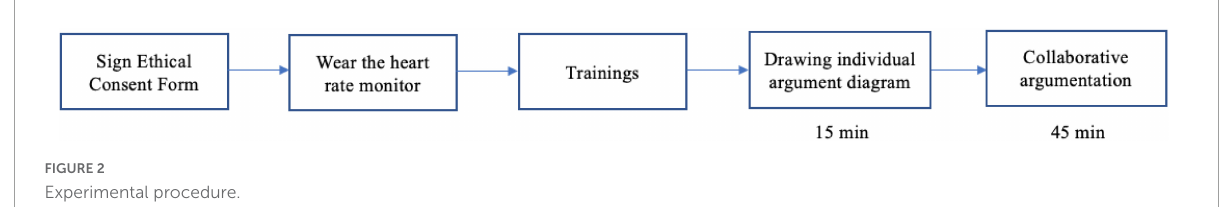
FIGURE2 Experimental procedure.